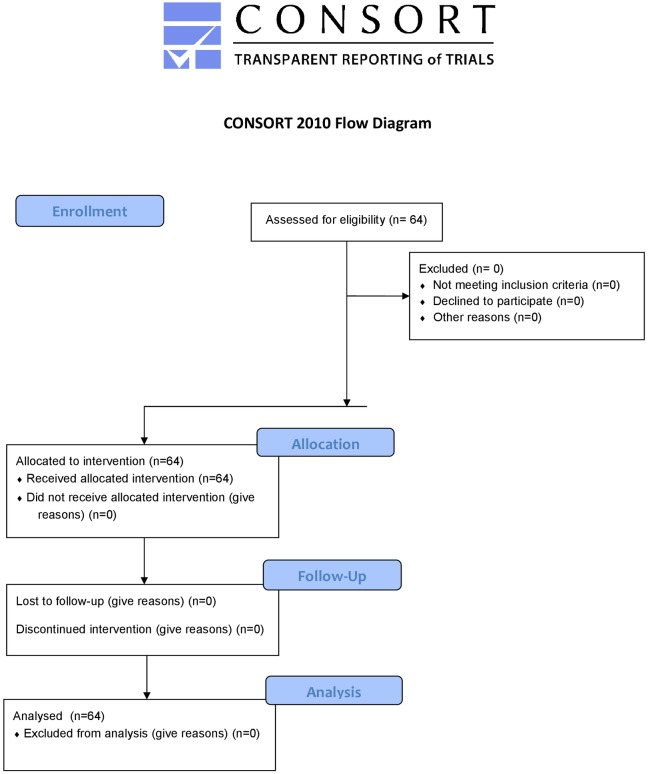
Consort flow diagram.